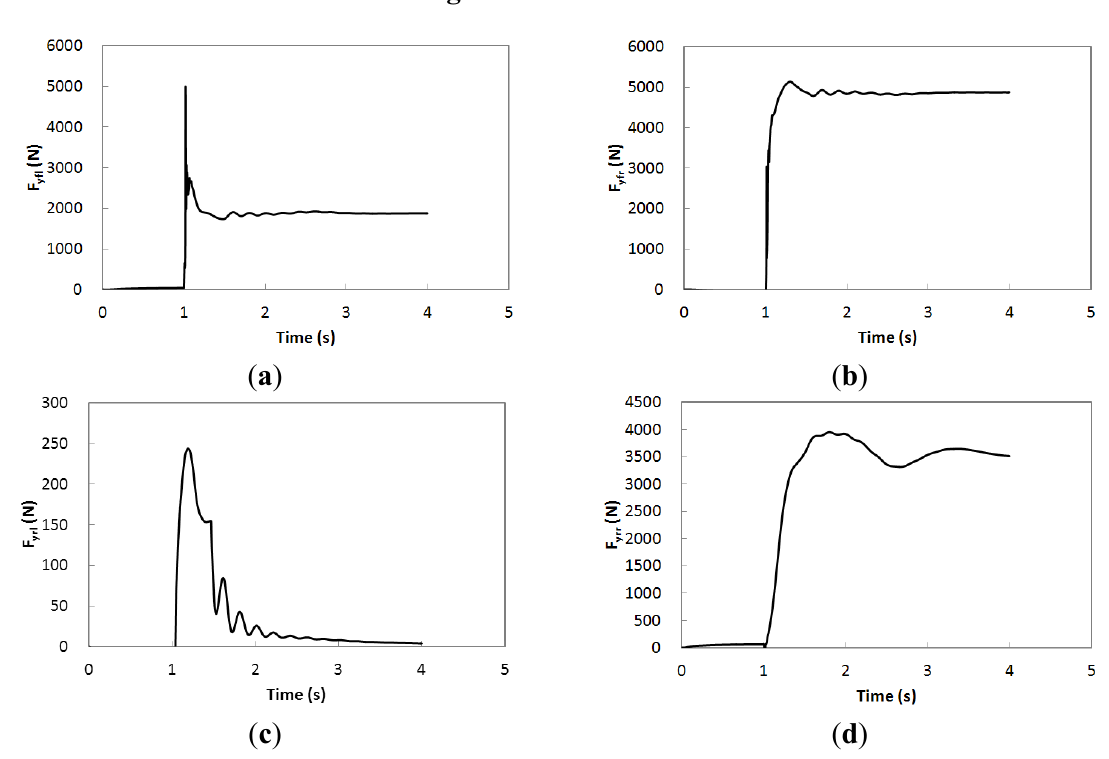
Figure 10. The lateral tire forces. ( a ) Front left wheel; ( b ) Front right wheel; ( c ) Rear left wheel; ( d ) Rear right wheel.